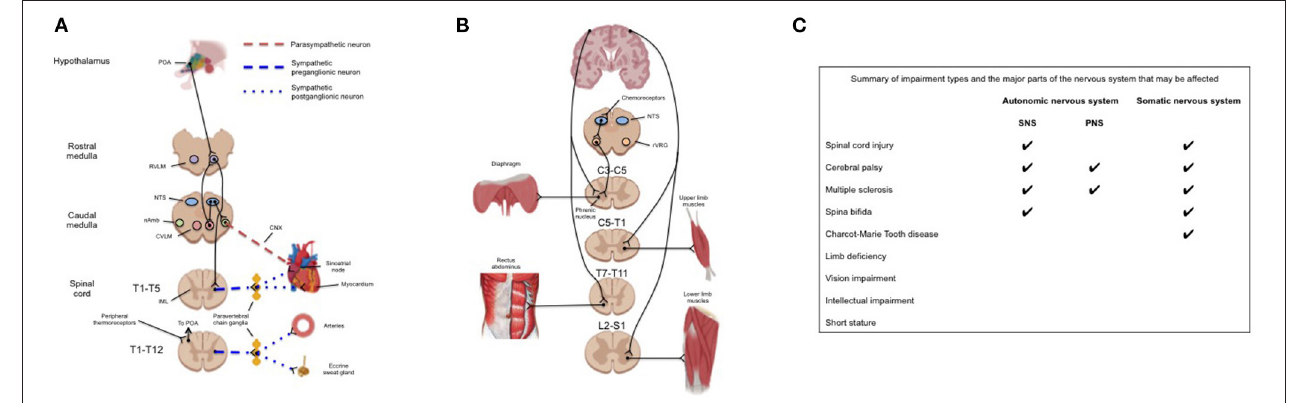
FIGURE 1 | (A) Neuroanatomical pathways responsible for the cardiovascular and thermoregulatory response to exercise. Although these responses are integrated within the brainstem the efferent pathways of the sympathetic response pass through the spinal cord and paravertebral chain ganglia. Impairments to these pathways may be at the level of the brainstem (cerebral palsy), spinal cord (spinal cord injury), or peripheral nerves (e.g., multiple sclerosis). (B) (Left) Anatomical pathways providing neural drive for the primary muscles of inspiration (diaphragm) and active expiration (rectus abdominus). Pacing of the diaphragm by the rVRG may be overridden by central command and therefore affected by impairments in motor pattern generation (e.g., cerebral palsy); (Right) pathways providing neural drive to upper and lower limb skeletal muscles. (C) Summary of common impairment types among para-athletes and which nervous system/s that the impairment may affect. CNX, tenth cranial nerve; CVLM, caudal ventrolateral medulla; IML, intermediolateral cell column; nAmb, nucleus ambiguus; NTS, nucleus tractus solitaries; POA, preoptic area of the anterior hypothalamus; PNS, parasympathetic nervous system; RVLM, rostral ventrolateral medulla; rVRG, rostral ventral respiratory group; SNS, sympathetic nervous